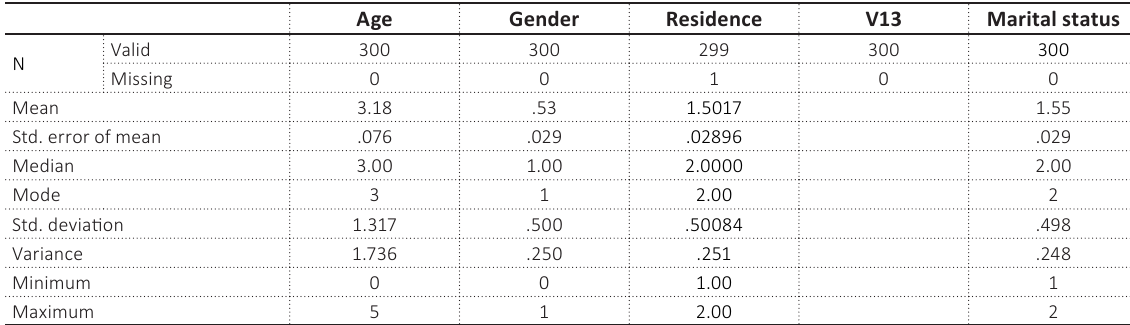
Table 15. Statistics